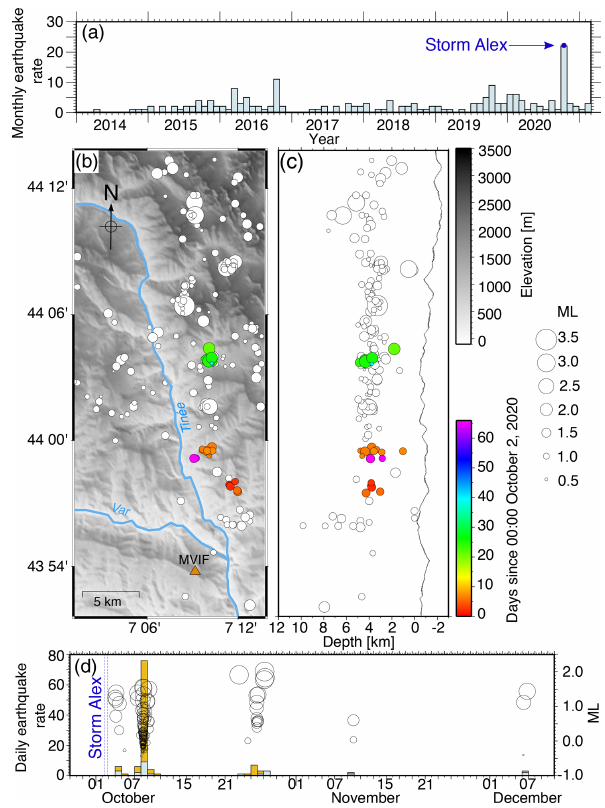
Figure 3. Seismic activity of the Tinée valley. (a) Monthly seis- mic activity between January 2014 and March 2021 detected by the SeisComP3 system. The blue arrow indicates the occurrence of Storm Alex. (b) Map of the seismicity over the period 2014– 2021 located by the SeisComP3 system. Colored circles are earth- quakes following Storm Alex. White circles are background seis- micity. The orange triangle represents the seismological broadband station MVIF. (c) North–south cross section displaying the depth range of the seismicity with respect to the sea level and the line is the average elevation of the map in (b) . (d) Daily rate (left axis) and local magnitude (right axis) for the seismic activity following Storm Alex. Gray bars are the number of earthquakes detected by the Seis- ComP3 system. The orange bars are the number of earthquakes de- tected by template matching. Black circles represent the detected earthquakes. The size is proportional to the magnitude. Dashed blue lines indicate the duration of Storm